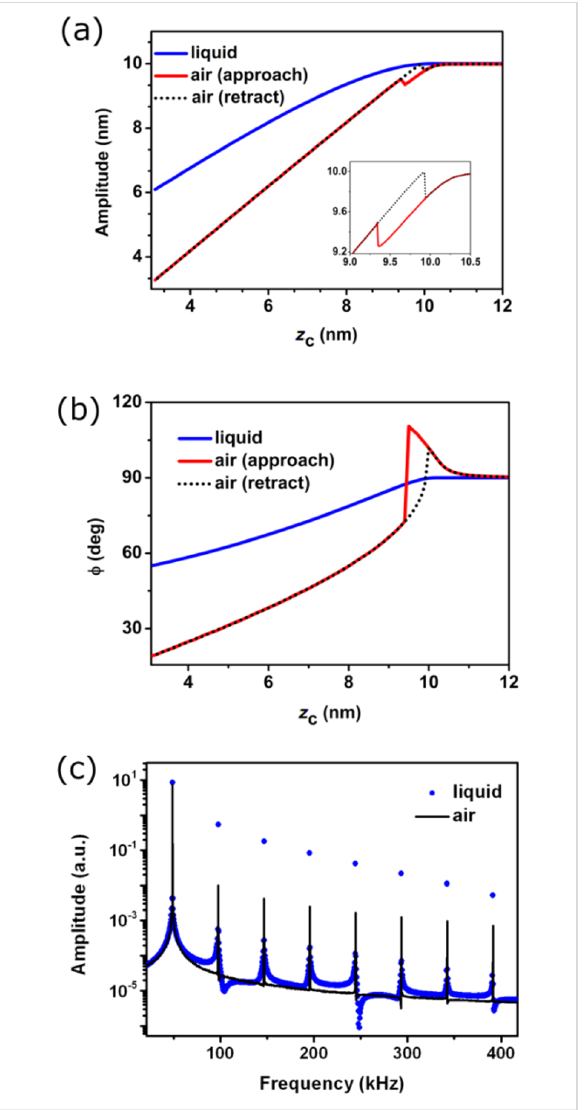
Figure 3: AM-AFM comparison of cantilever dynamics, air versus liquid. (a) Amplitude versus average tip–surface distance curves for low and high Q values. The inset shows the details of the hysteresis in the amplitude (approaching and retraction cycles). (b) Corresponding phase shift curves. (c) Spectra of the amplitude components taken at z c = 7 nm. The approaching (continuous line) and retraction curves (dots) are also shown in (a) and (b) for Q = 255.